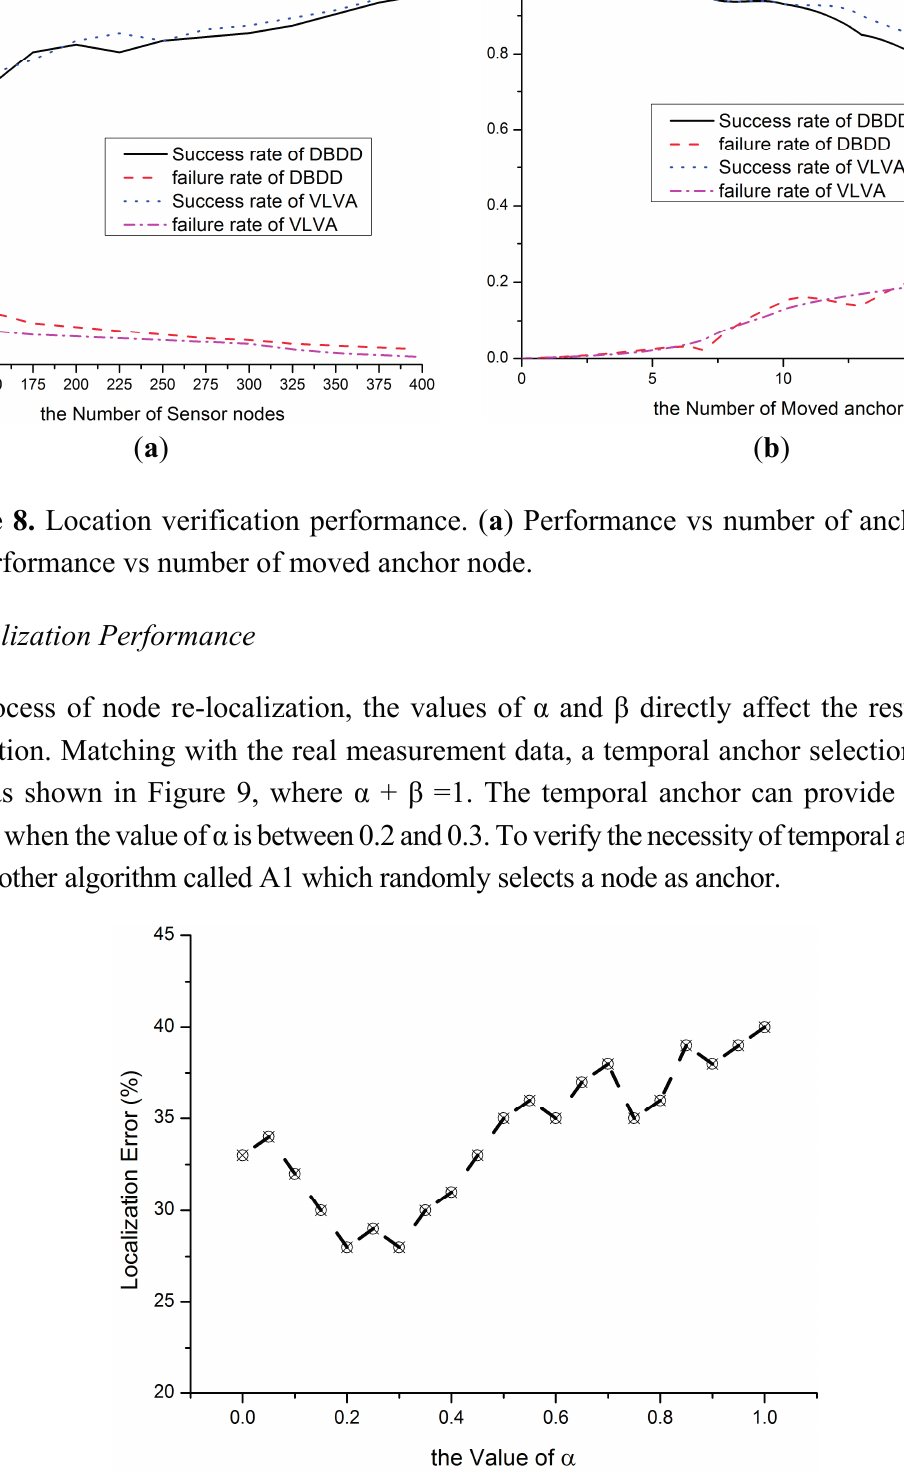
Figure 9. Coefficients’ variation vs. localization